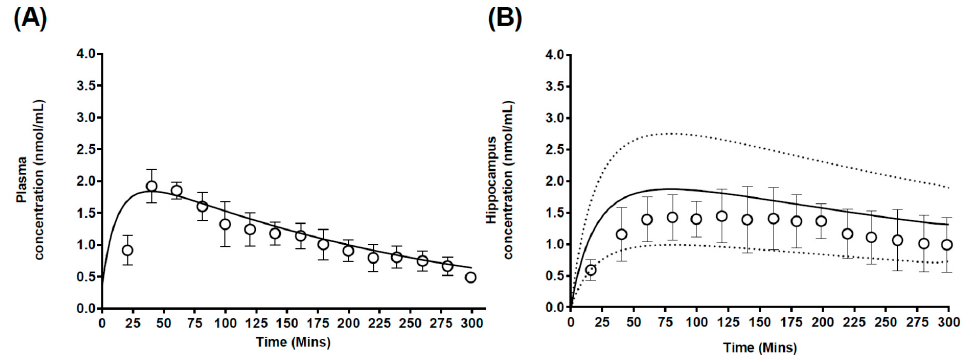
Figure 6. Simulated mean carbamazepine plasma and hippocampus concentration-time profiles. Simulated mean values of carbamazepine-time profiles in ( A ) plasma and ( B ) hippocampus after a 2.5 mg/kg carbamazepine dose. Open circles and errors bars represent literature reported mean and ± SD. Solid black line represents model prediction mean profiles and dashed lines indicated 95th and 5th percentiles. Table 4. Summary of predicted and observed pharmacokinetic parameters of carbamazepine in plasma and hippocampus brain regions in rats.